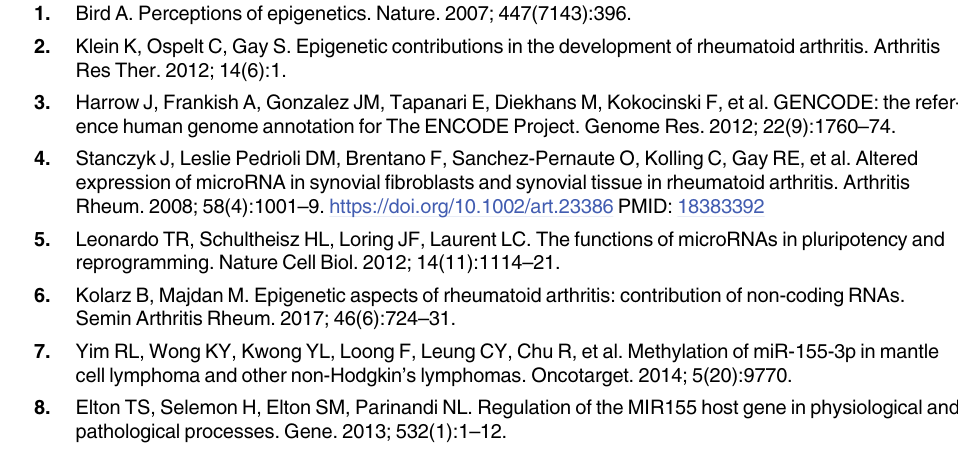
S2 Table. MiR-155 methylation and expression levels according to the way of treatment. S1 Fig. MiR-155 expression and methylation in the treatment